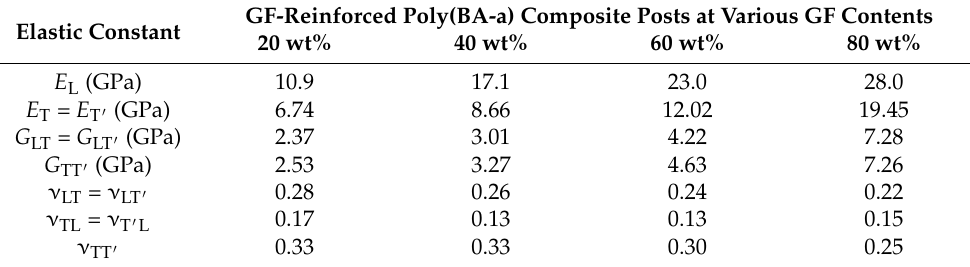
Table 2. Summarized elastic properties for the orthotropic materials used for the FEA.